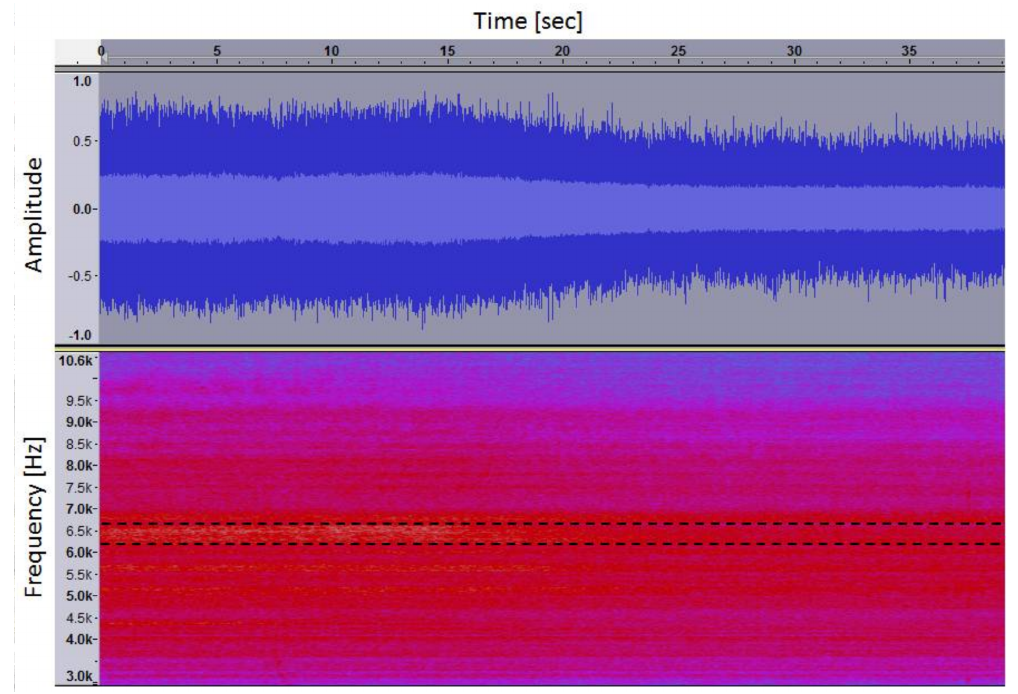
Figure 7. Time series and spectrogram of exemplary working chamber acoustic signal